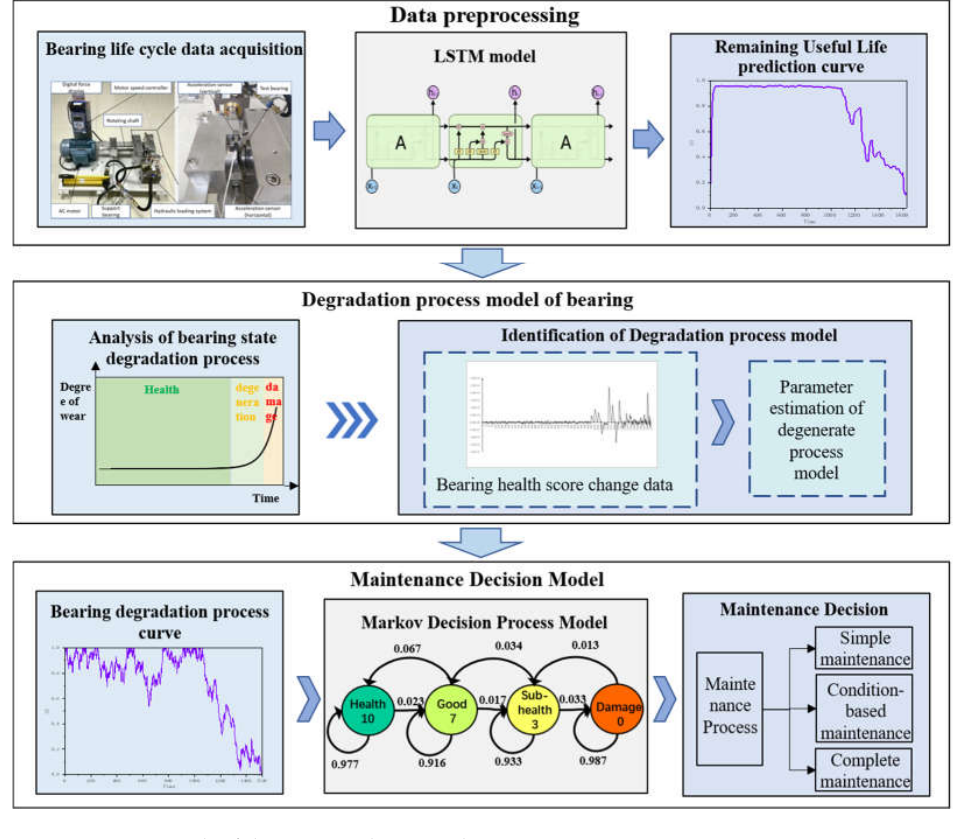
Figure 1. Framework of the proposed approach.